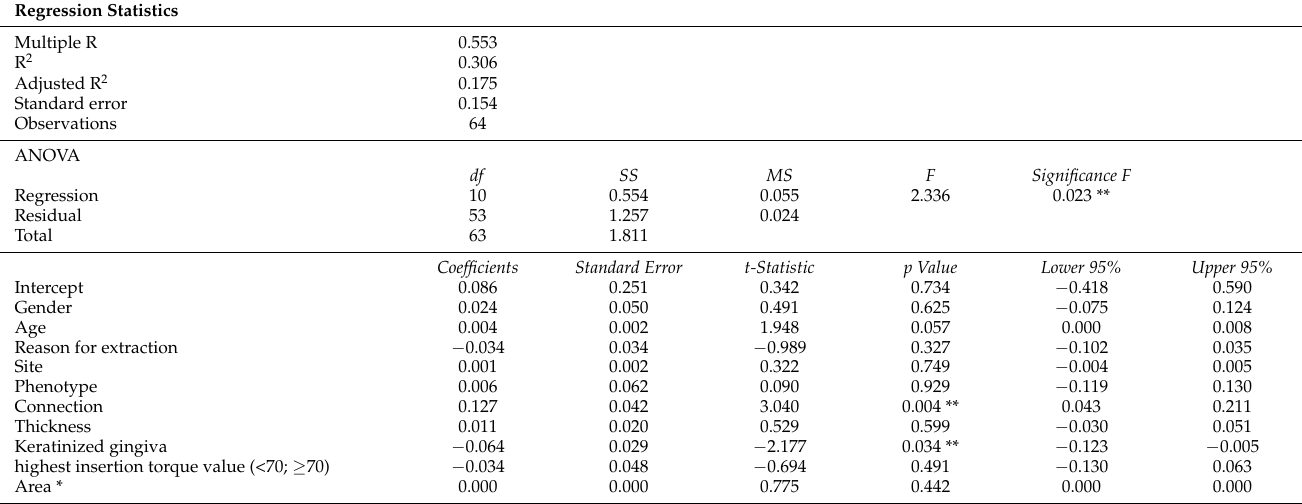
Table 4. Results of the regression model * Signed area bounded by the x-axis (time) and the torque curve. ** Statistically